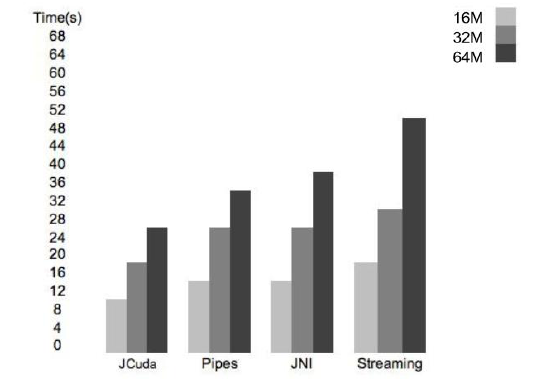
Fig. 11. Performance Comparison over Word Count Appli- cation